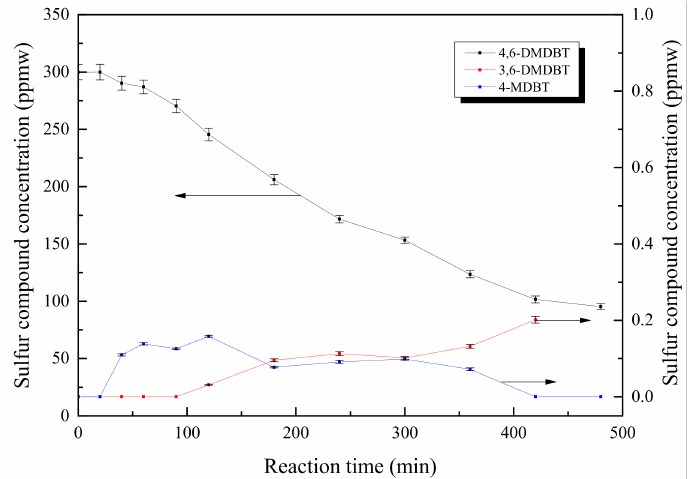
Figure 7. The conversion of 4,6-DMDBT and the formation of 4-MDBT and 3,6-DMDBT with time on stream over CoMo/AZ (Reaction conditions: 648 K, 8.96 MPa, 1000 rpm, 20 g catalyst, 200 g feed (4,6-DMDBT with 300 ppm sulfur in